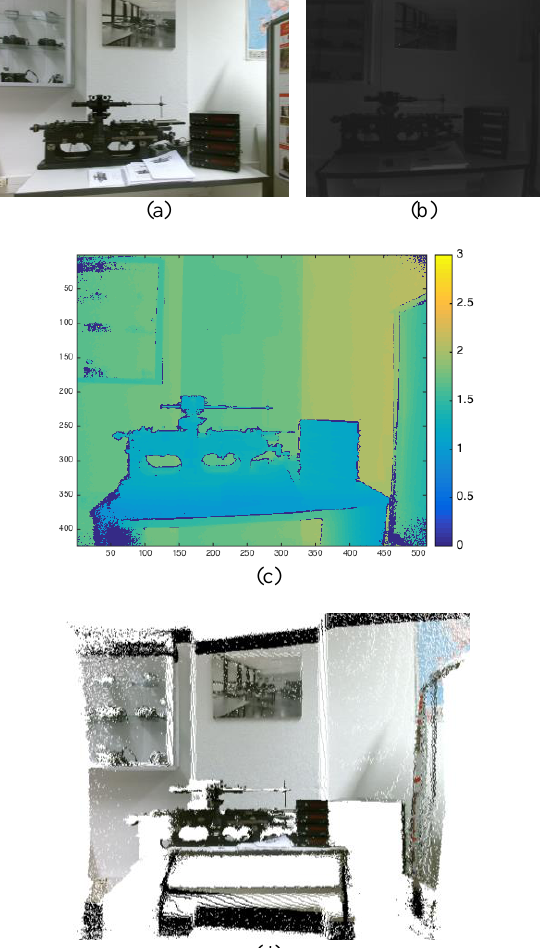
Figure 2. Output data: (a) RGB image; (b) infrared